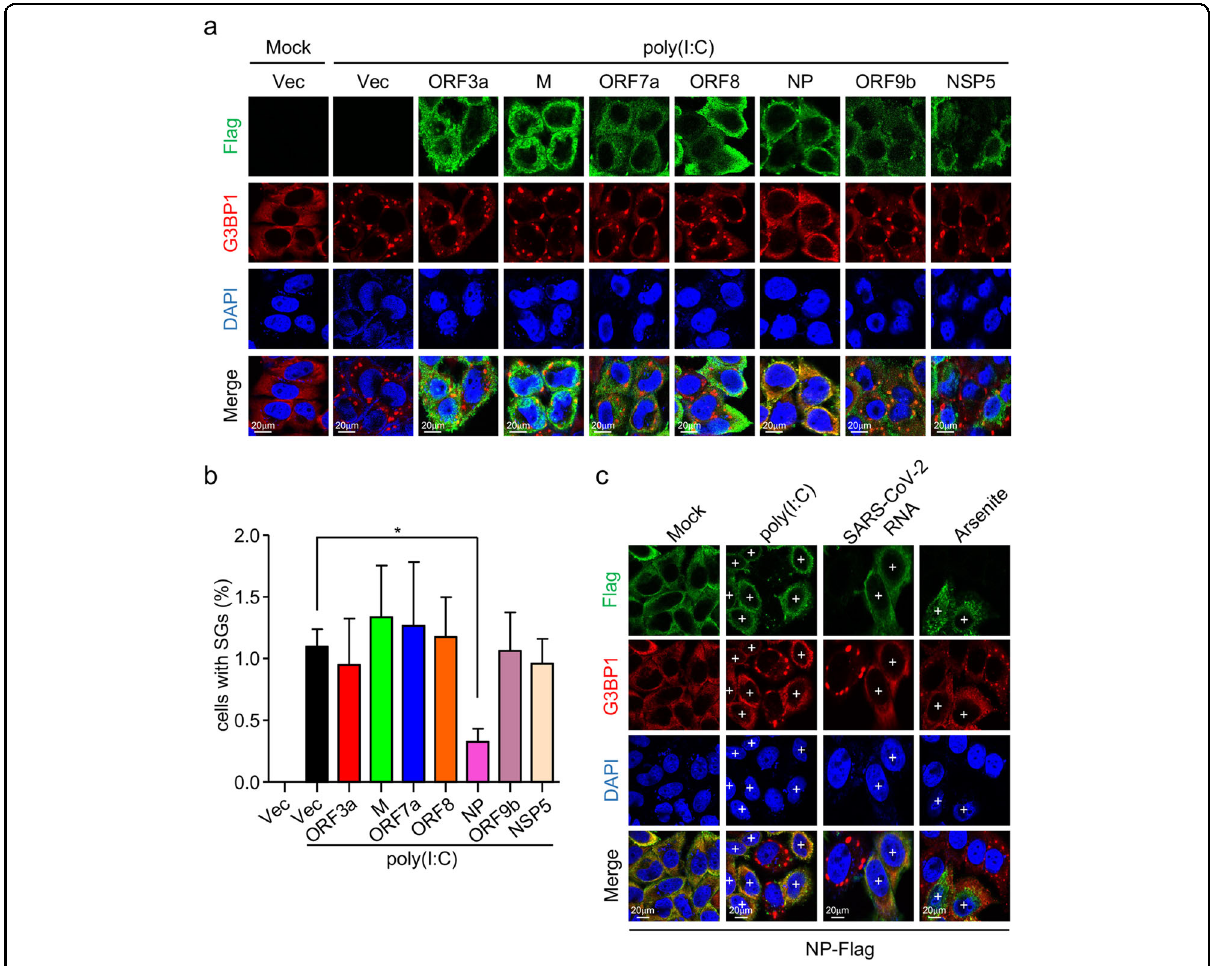
Fig. 3 SARS-CoV-2 NP inhibits SG formation. a Effects of SARS-CoV-2 proteins on poly(I:C)-induced SG assembly. HeLa cells were transfected with plasmids encoding the indicated Flag-tagged SARS-CoV-2 proteins for 12h, then transfected with poly(I:C) (2 μ g) for 10h. Cells were immunostained for Flag (green) and G3BP1 (red). Nuclei were stained with DAPI (blue). The cells were observed with a Nikon confocal microscope under a 60× oil objective. b Quantitative analysis of the cells (in a ) with G3BP1 foci. The percentage of cells containing SGs was quanti fi ed and at least 100 cells were counted each time. c SARS-CoV-2 NP impairs poly(I:C)-, SARS-CoV-2 RNA-, and sodium arsenite-induced SG assembly. HeLa cells were transfected with SARS-CoV-2 NP- Flag plasmid for 12h, then transfected with poly(I:C) (2 μ g) or SARS-CoV-2 RNA (1 μ g) for 10h or treated with sodium arsenite (1mM) for 1h. Cells were immunostained for Flag (green) and G3BP1 (red). Nuclei were stained with DAPI (blue). The cells were observed with a Nikon confocal microscope under a 60× oil objective. “ + ” indicates the cells expressing NP. Graphs show means±SD, n = 3. * P <0.05 (Student ’ s t-